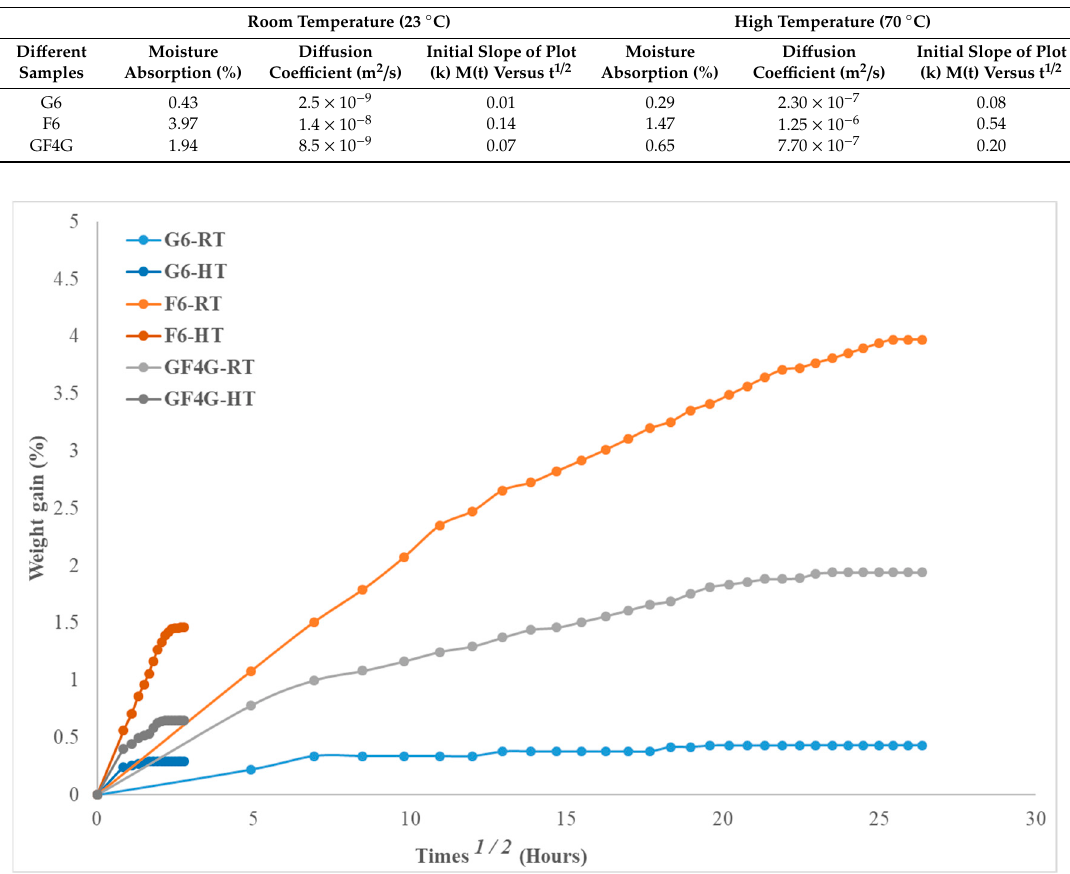
Figure 1. Moisture absorption versus square root of time at room temperature and high temperature.